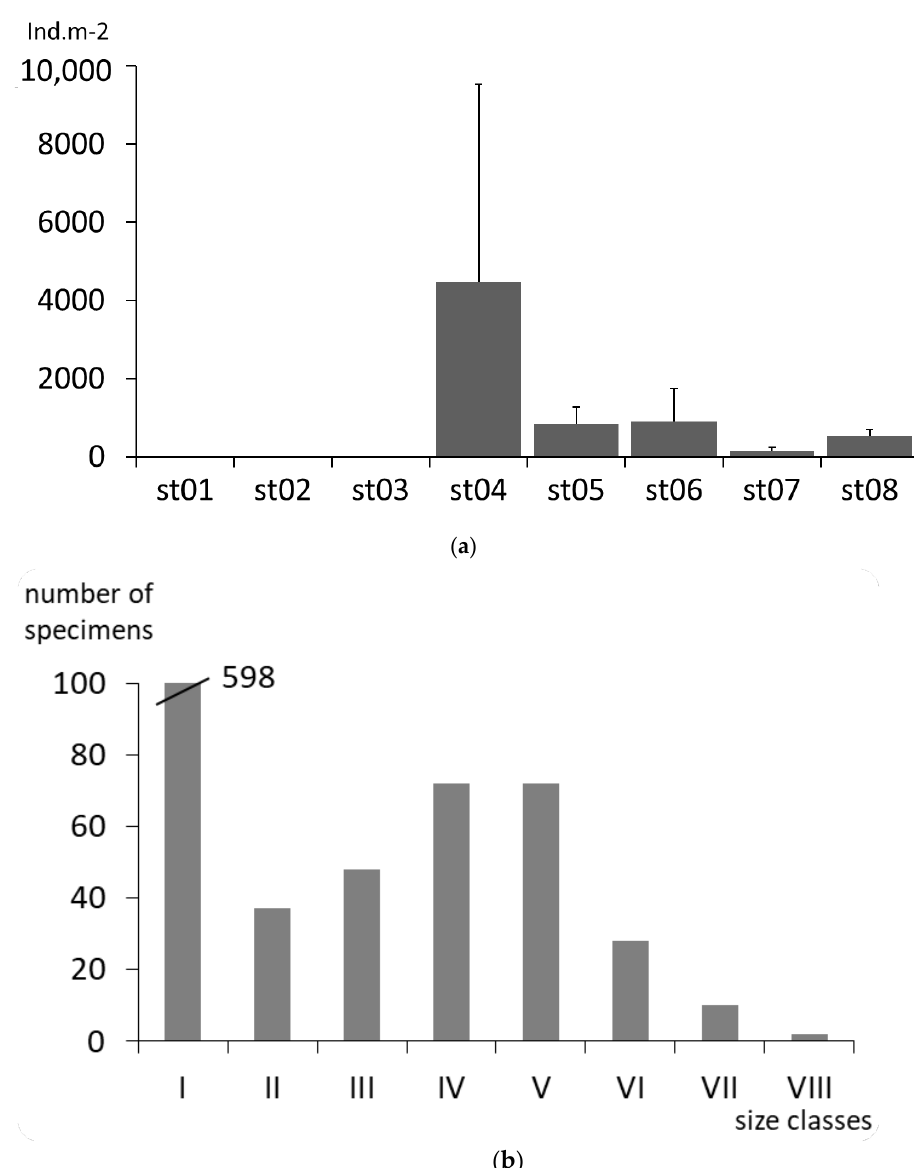
Figure 2. ( a ) Mean number of specimens (±standard deviation) collected in the eight stations in the River Adda. ( b ) Size-frequency distribution of the population sampled on 31 August 2021. Table 1. Main environmental parameters recorded during the sampling. Table 2. Results of the pairwise Dunn test between D. villosus densities in each station. *: statistical significance, **: high statistical significance, ***: very high statistical